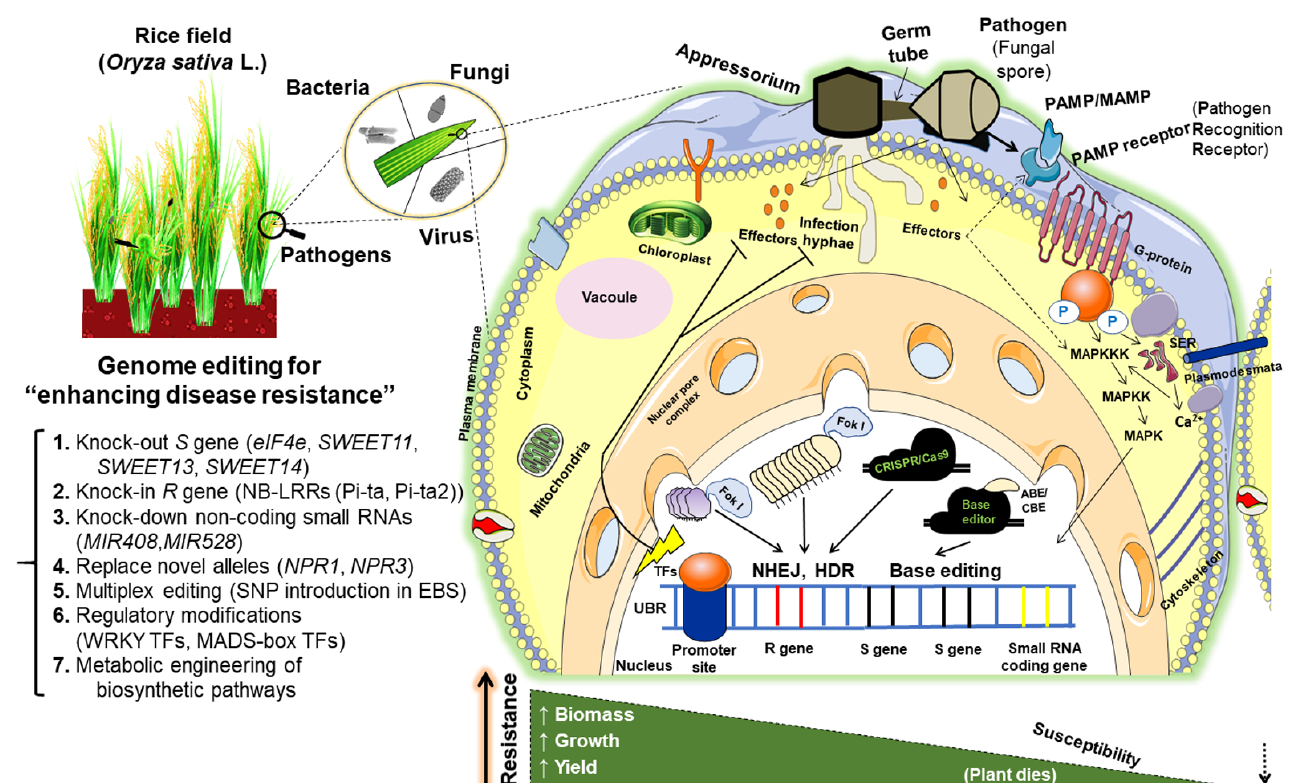
Figure 1. Schematic illustration representing the genome editing strategies adopted for the enhance- ment of disease resistance in rice. Different approaches are functional knockout of the host S genes via either deletion/mutation/replace of the coding sequences, modification of single nucleotide polymorphisms in the recessive allele of R genes through base editing, knock-down of non-coding regulatory RNAs (miRNAs) by Cas13, replacement of central regulators like NPR1, engineering the promoter cis-elements by multiplex editing, modification of negative TFs of plant defense, metabolic engineering of secondary metabolite (lignin) synthesis to favor plant defense, etc. These strategies have been applied to intervene in the different steps of pathogenesis events of fungi, bacteria, and viruses.